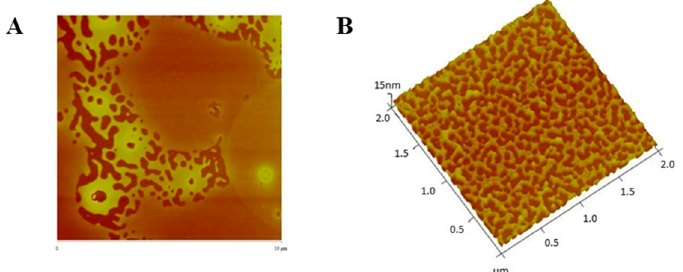
Figure 9. AFM images (2D and 3D images) with size scale of ( A ) PvD-loaded, and ( B ) empty CET conjugated NPs.